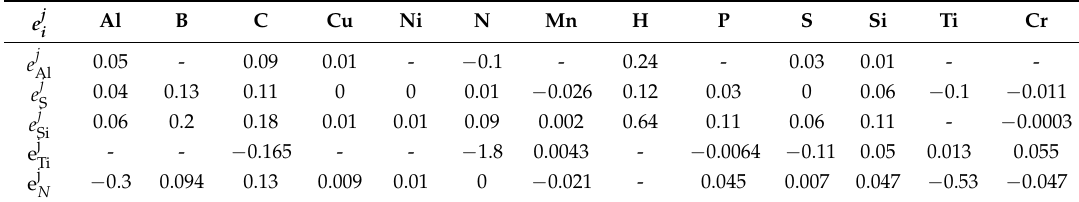
Table 4. First-order interaction coefficients in liquid iron at 1873